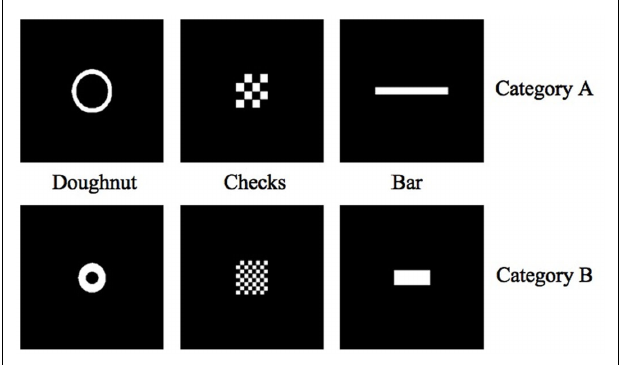
FIGURE 1 | Stimuli for Phase I of the experiment, the pre-training phase.